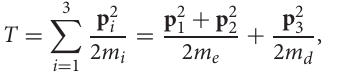
Table 5 . In fact, being a sum of Yukawa functions, the